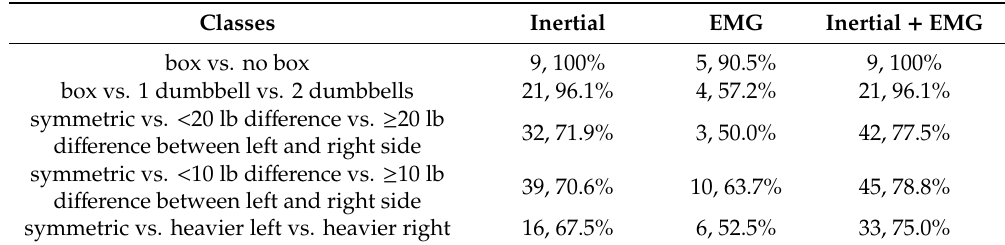
Table 1. Number of selected features and classification accuracies for all five classification problems using three input data types: only inertial, only electromyography (EMG), or inertial + EMG. In each field, the first value is the number of selected features while the second is classification accuracy. Results are given for the support vector machine-based classifier in case of EMG data alone and for the regression-based classifier in the cases of inertial data alone and the combination of inertial and EMG data, as these classifiers exhibited the highest accuracies for those data types.